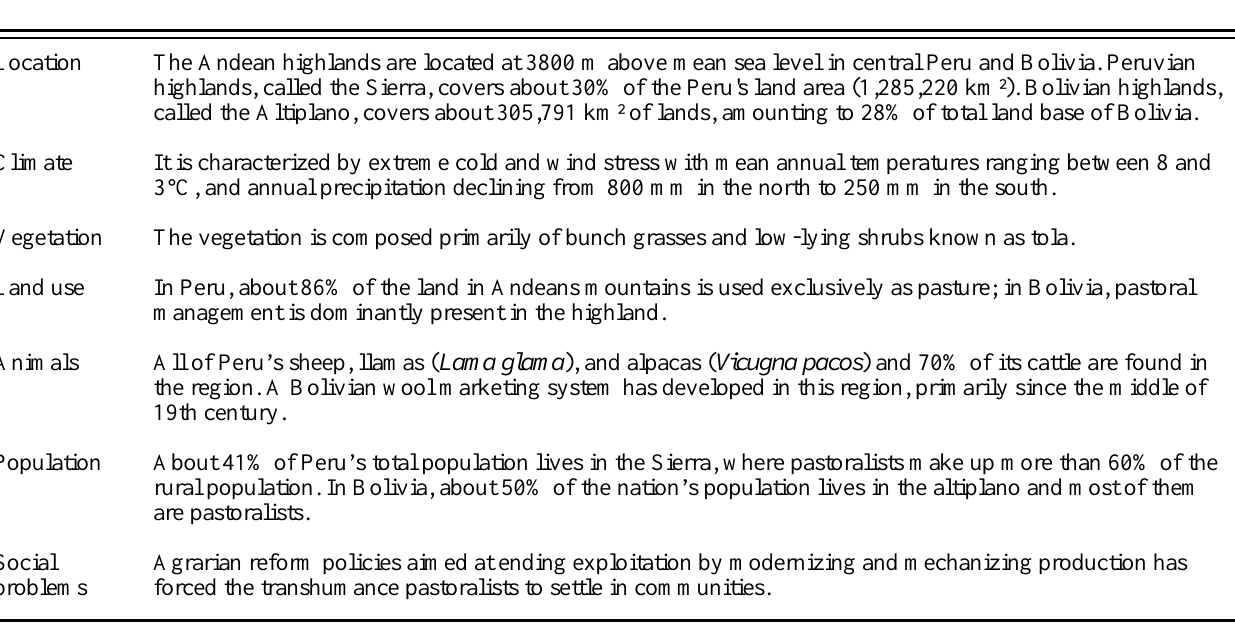
Table 4. General information on the Bolivian and Peruvian Andeans of South America (Pattie 1988, Kuznar 1991, Westreicher et al.